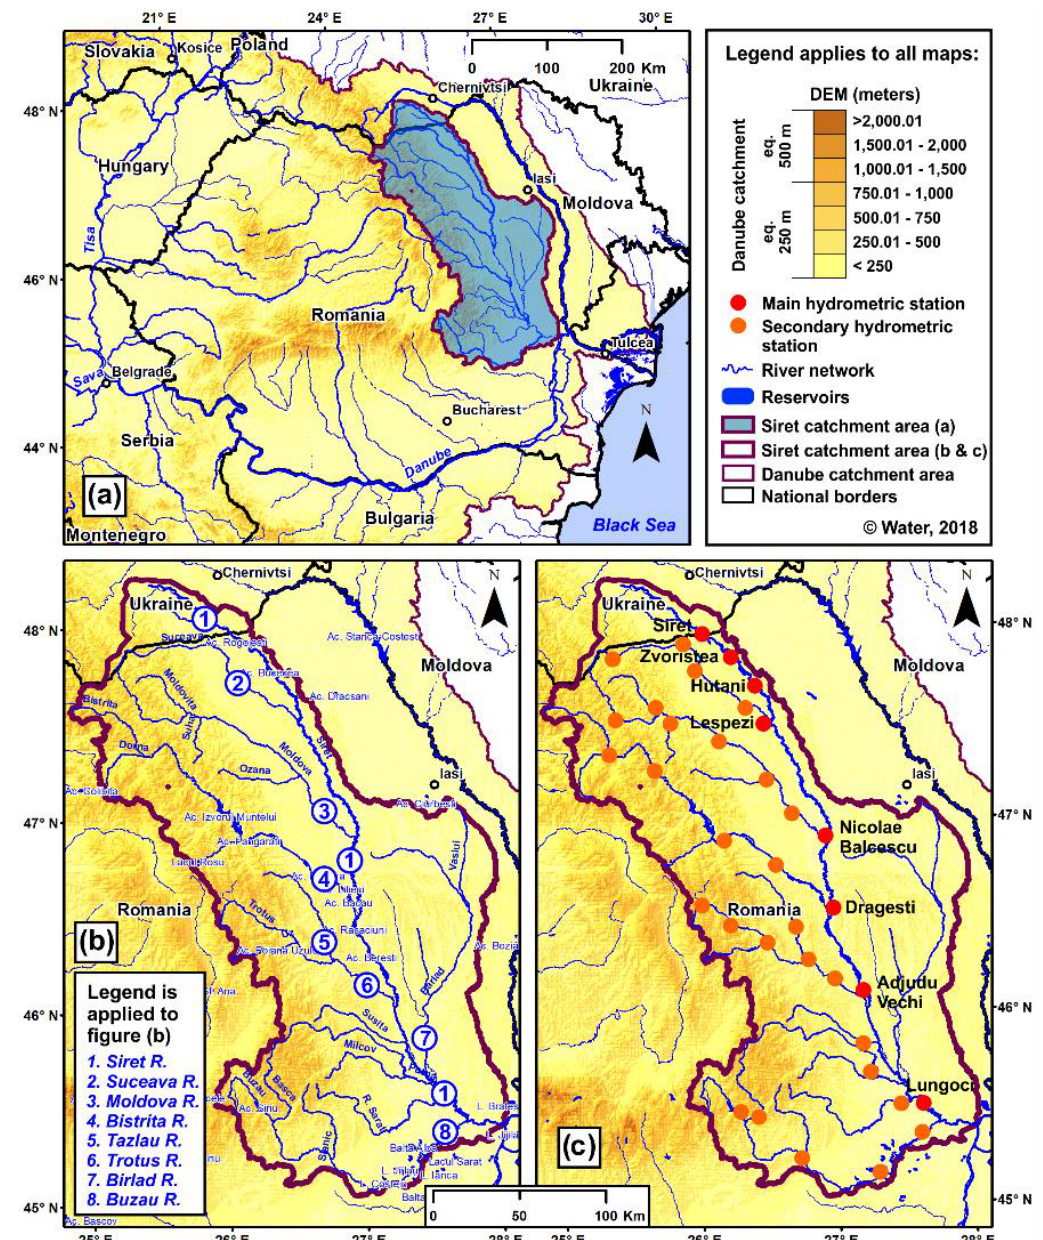
Figure 2. ( a ) Geographic location of the Siret catchment on the Romanian territory; spatial distribution of the ( b ) studied rivers and ( c ) hydrometric stations, with the role of mitigating floods in the Siret catchment area.